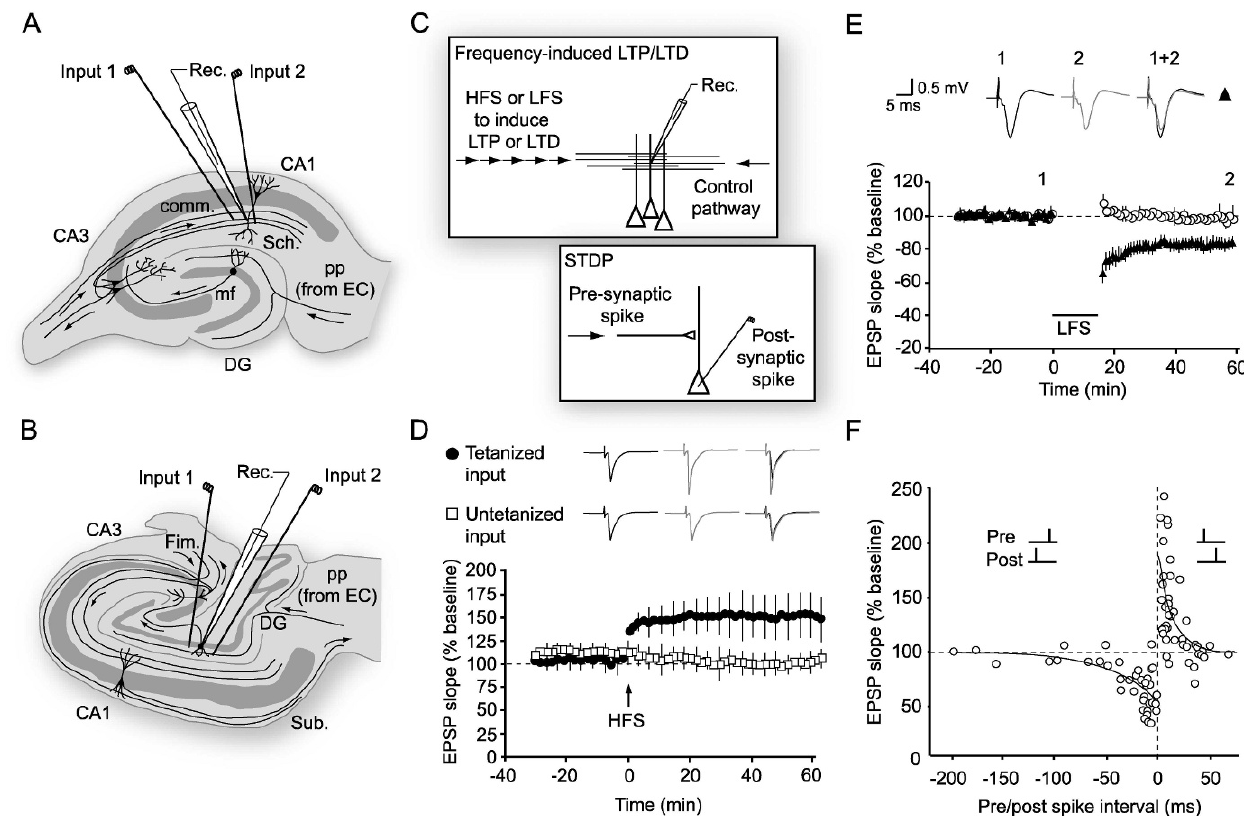
Figure 1 - LTP and LTD: Induction protocols ( A ) Schematic of the rodent transverse hippocampal slice, the mostly commonly used preparation for studying LTP, LTD and related phenomena. In the configuration shown, an extracellular recording electrode is placed among apical dendrites of CA1 pyramidal cells, and stimulating electrodes are positioned in the Schaffer (Sch) collaterals to stimulate two separate input pathways. ( B ) A transverse view of the human hippocampus showing electrode placements for stimulating and recording in the dentate gyrus. 67 ( C ) Diagram showing how LTP and LTD are induced in a pathway (input 1) by high- or low-frequency stimulation (HFS or LFS) respectively, while a second pathway acts as a control (see D,E). A related form of plasticity, known as spike timing-dependent plasticity (STDP), can be induced by repeated pairing of presynaptic and postsynaptic firing. Depending on the relative timing, LTP or LTD is induced (see F). ( D ) LTP in a two-pathway experiment in the dentate gyrus of human hippocampus. Normalized values of the slope of the population EPSP are plotted for potentiated and control pathways. After a baseline period of test stimulation at 1 stim/min, a brief burst of high-frequency stimulation (HFS, 100 Hz for 1 sec, arrow) is delivered. The potentiation of the response to resumed test stimulation is present immediately after HFS, and persists for at least one hour (black circles) while the control pathway (open squares) remains unaffected, demonstrating the input-specificity of LTP. 67 Sample field potentials are shown pre- and post-tetanus. ( E ) LTD in area CA1 of rat hippocampal slices induced by low frequency stimulation (LFS, , 1 Hz) for around 15 minutes (bar). This form of plasticity is also input-specific; only the pathway subjected to LFS is depressed (black circles) (adapted from 4 ). ( F ) The polarity of synaptic plasticity induced by STDP protocols is determined by the relative timing of pre- and post-synaptic spiking. If an action potential is repeatedly evoked before pre-synaptic stimulation then, provided the interval is brief enough, a depression of synaptic strength ensues. If the order is reversed so that pre-synaptic activation precedes the post-synaptic spike, as would happen if the synaptic input contributed to triggering an action potential, then LTP is induced (rat hippocampus, adapted from